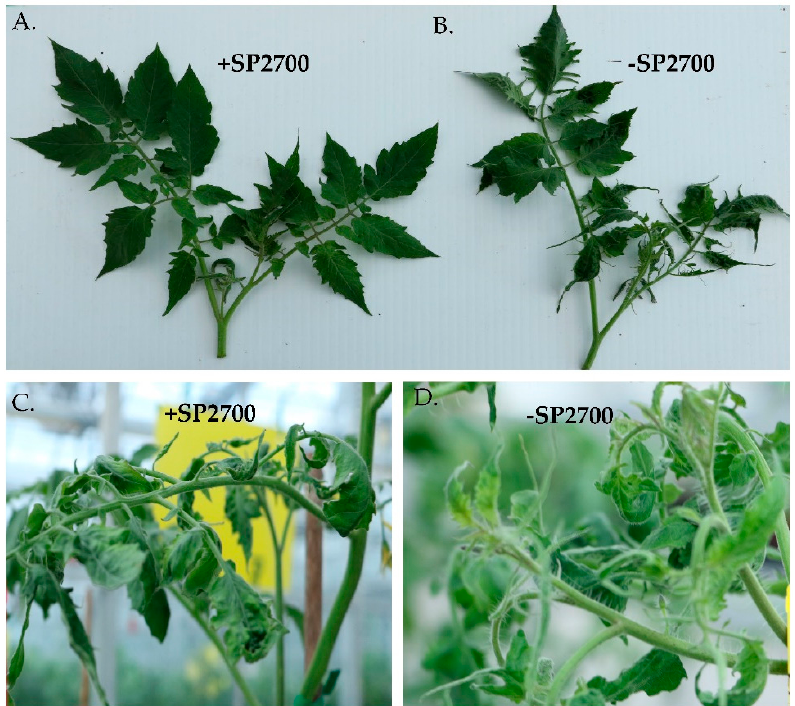
Figure 1. Symptom expression on tomato ‘Paipai’ plants that were pretreated with or without SP2700 upon inoculation with ToBRFV. ( A ) A tomato plant with pre-treatment with SP2700 showed normal appearance 3 weeks post inoculation (wpi) with ToBRFV. ( B ) A tomato plant without SP2700 pre-treatment displayed mottling and narrow leaves 3 wpi (right). ( C ) Symptom expression on ToBRFV-infected tomato plants that were pre-treated with SP2700 at 6 wpi. ( D ) +Symptom expression on ToBRFV-infected tomato plants without SP2700 pre-treatment at 6 wpi.